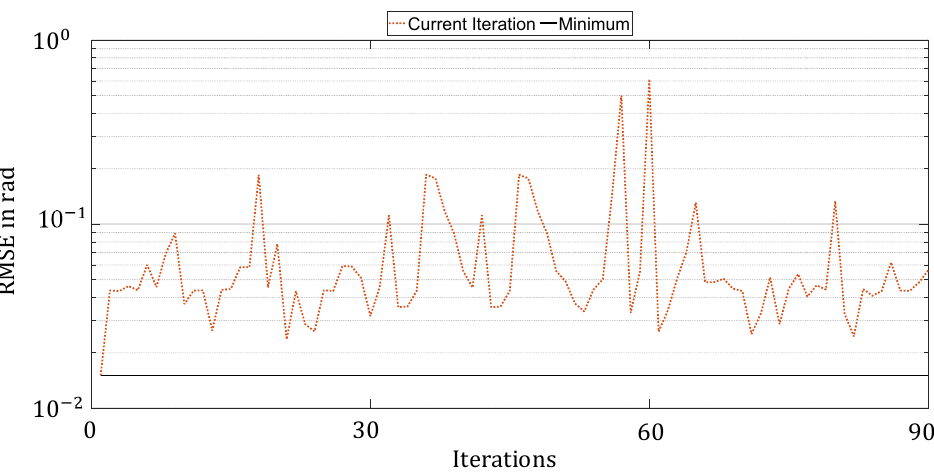
Figure 8. Progress of hyperparameter optimization with Hyperband over 90 iterations, corresponding to 9 HP evaluations.